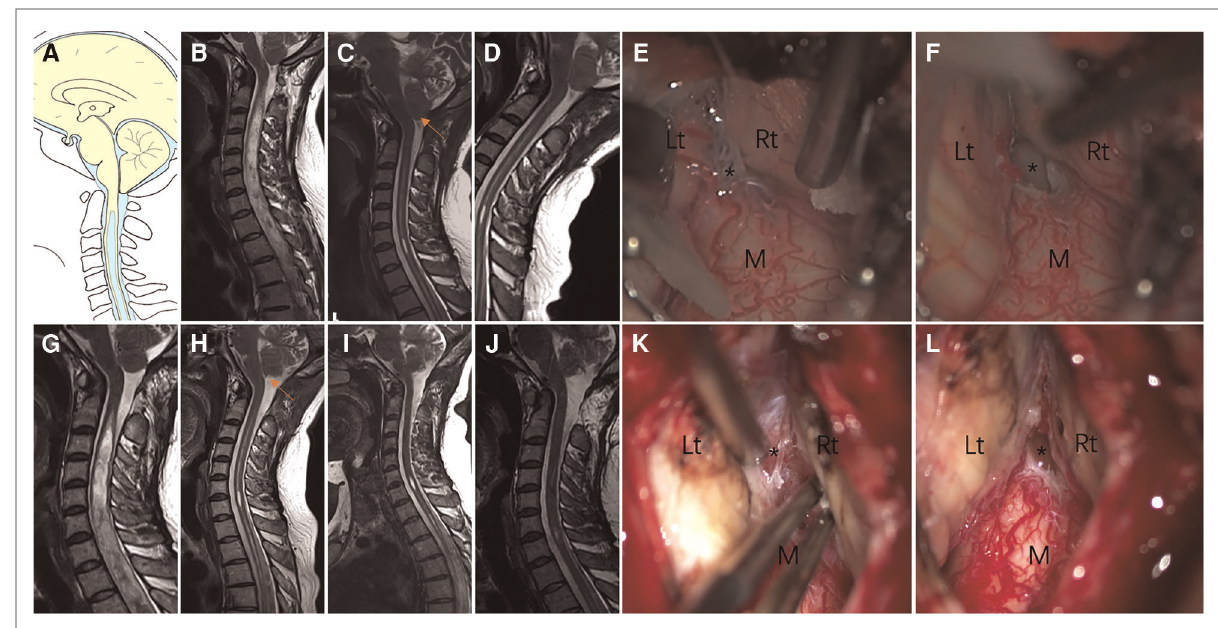
FIGURE 2 Case presentation of Group I, a 31-year-old woman presented with upper extremity paresthesia. ( A ) Schematic drawings of the foramen magnum region, sagittal view. Midsagittal T2-weighted MRI scans of the cranio-cervical before the initial craniocervical decompression surgery ( B ), 3 ( C ) months after the initial surgery, and 6 ( D ) months after the initial surgery are shown. ( E,F ) An obvious veil obstructing the foramen of Magendie (asterisk). ( G ) 1 year after the initial surgery. Postoperative MRI after 3 months ( H ), 6 months ( I ) and 1 year ( J ) of revision surgery showing good decompression of the posterior fossa. ( K,L ) Veil obstructing the foramen of Magendie was removed and tonsil was coagulated. Lt, left tonsil; Rt, right tonsil; M, medulla